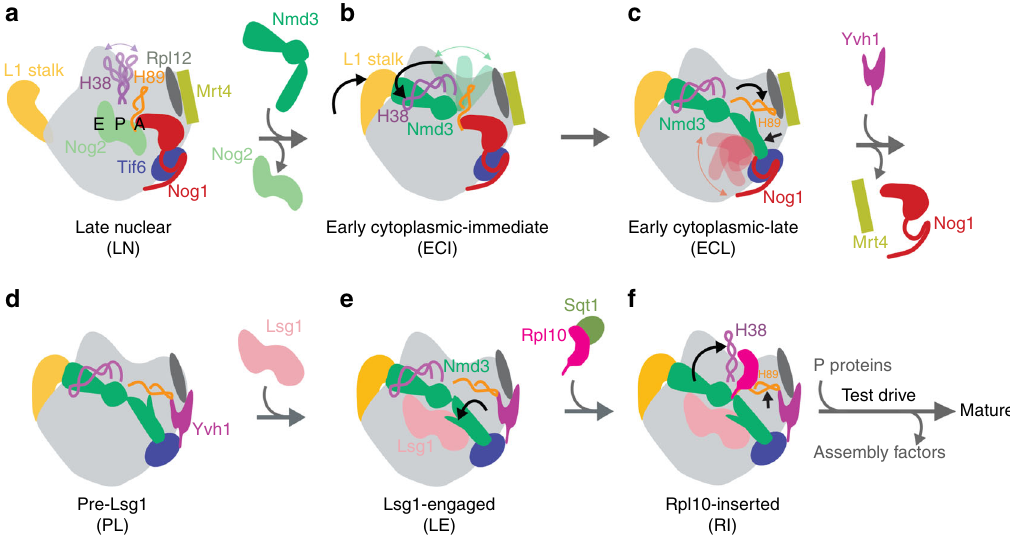
Fig. 5 Summary of 60S maturation concluding with Rpl10 (uL16) insertion. a Late nuclear particle before Nmd3 loading. H38 tip is fl exible while H89 is displaced by the N-terminal domain (NTD) of Nog1 in the A site. Rpl12 (uL11) and Mrt4 both bind to the P stalk. b Early cytoplasmic-immediate particle showing that the nuclear export factor Nmd3 closes the L1 stalk and captures H38. The NTD of Nog1 remains in the A site, displacing H89, and the NTD of Nmd3 is not discernible, probably because of its high mobility before docking onto Tif6. c In the early cytoplasmic-late particle, the NTD and GTPase domain of Nog1 have been released from the A site, allowing Nmd3 to dock on Tif6 and bind H89, which is rearranged to its near-mature position. Note that the Nog1 C terminus remains in place while the NTD and GTPase domain are not discernible, likely due to high fl exibility after displacement from the A site. d In the pre-Lsg1 particle, multiple assembly factors have been released. The release of Nog1 allows the binding of Yvh1 to release Mrt4 from the P stalk. e The Lsg1-engaged particle reveals a rotation of the NTD of Nmd3 away from H89 to engage with Lsg1. This releases H89 from Nmd3 to prime the subunit for the insertion of Rpl10. f The insertion of Rpl10 causes retraction of both H38 and H89 to their mature positions to stabilize Rpl10 in its binding site. The complete release of Nmd3 from H38 and H89 poises Nmd3 for its imminent release. Subsequently, the nascent 60S subunit undergoes a test drive using molecular mimics of translation factors before licensing it for bona fi de